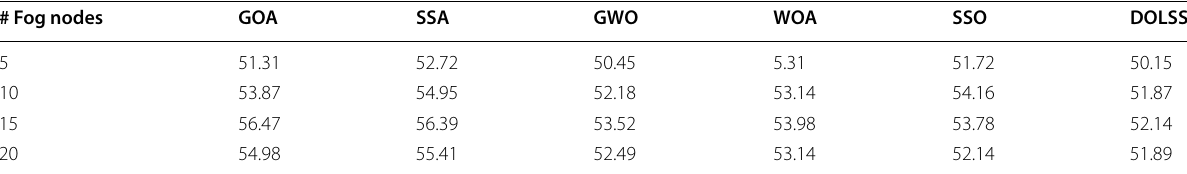
Table 2 Execution time for Jobs # Fog nodes